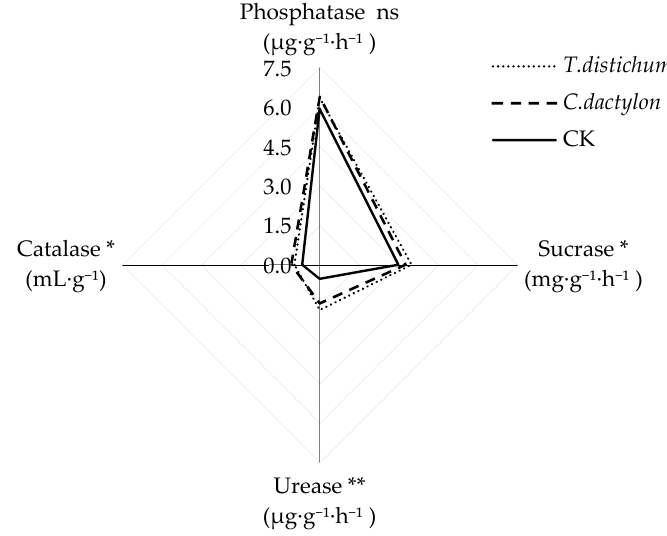
Figure 2. Radar graphs illustrating enzyme activities after revegetation. * and ** refer to significant differences between planted and unplanted soils at p < 0.05 and p < 0.01, respectively; ns refers to no significant difference.